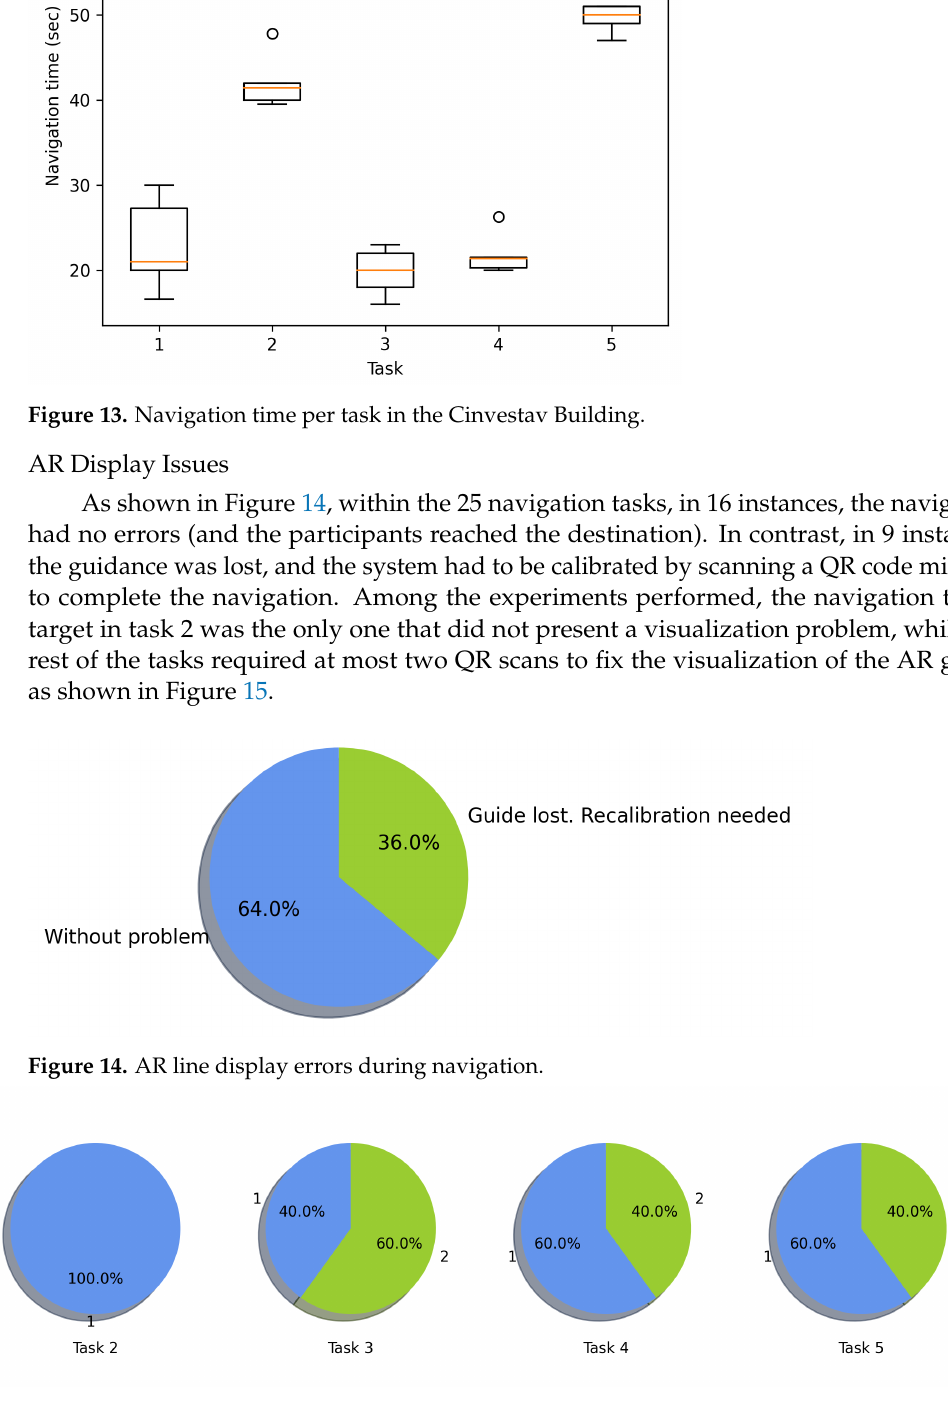
Figure 15. Ratio of QR scans to set position by task. The category values represent the number of times a QR scan was required to complete the